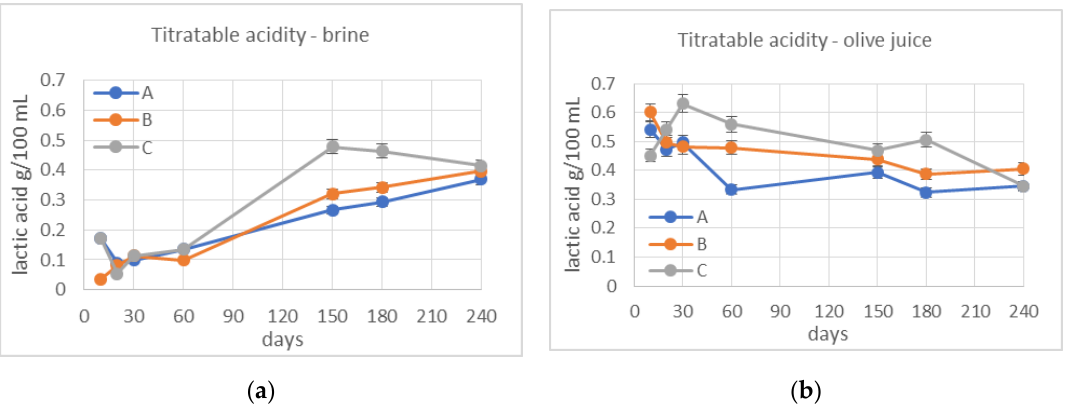
Figure 5. Evaluation of the titratable acidity in the brine ( a ) and in the olive juice ( b ) during the fermentation. A = spontaneous; B = inoculated with L. plantarum B1; C = inoculated with L. plantarum B1 + B51 + B124. The data are expressed as the mean of two replicates ± standard deviation.